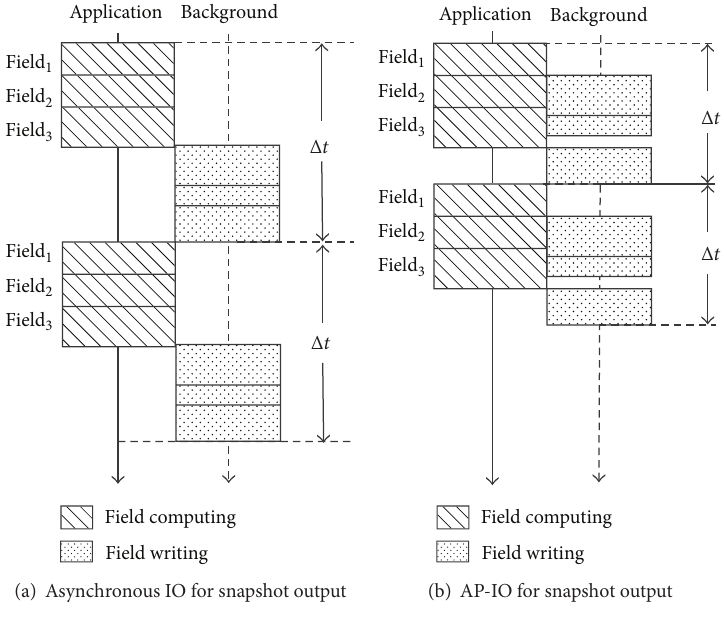
Figure 3: Asynchronous IO versus AP-IO for CFD snapshot output.